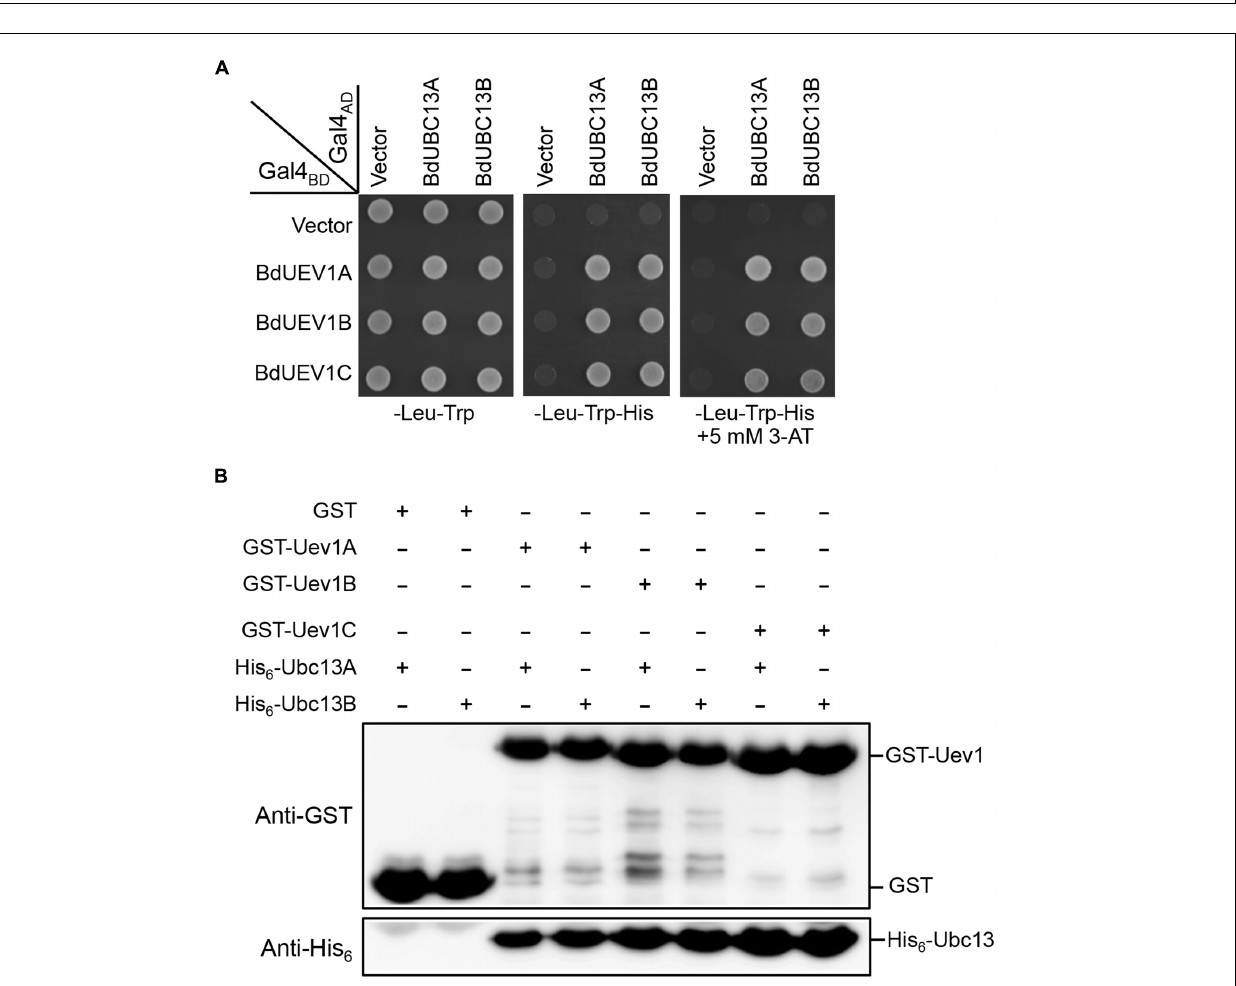
FIGURE 1 | Analysis of UEV1s from different organisms. (A) Amino acid sequence alignment of BdUev1s and Uevs from other organisms. The sequences were aligned and edited using BioEdit 7.0.9. Critical residues for UEV functions are indicated with asterisks underneath the residue. Sc, S. cerevisiae (NP_011428); Mm, Mus musculus ( MmMMS2 = NP_076074, MmUEV1A = NP_075719.1); Hs, Homo sapiens ( HsMMS2 = NP_003341.1, HsUEV1A = NP_068823.2); Dr, Danio rerio ( DrMMS2 = NP_998680.1, DrUEV1 = NP_001032479); At, A. thaliana ( AtUEV1A = NP_564191, AtUEV1B = NP_564994, AtUEV1C = NP_850259, AtUEV1D = NP_001190073); Os, Oryza sativa Japonica Group ( OsUEV1A = XP_015632881, OsUEV1B = XP_015620277, OsUEV1C = XP_015611980, OsUEV1D = XP_015635908); Bd , B. distachyon ( BdUEV1A = KQK13622, BdUEV1B = XP_003577901, BdUEV1C = XP_003577953). (B) Phylogenetic analyses of UEV family CDSs from different organisms. The phylogenetic tree clustering was conducted by using MEGA6.0.